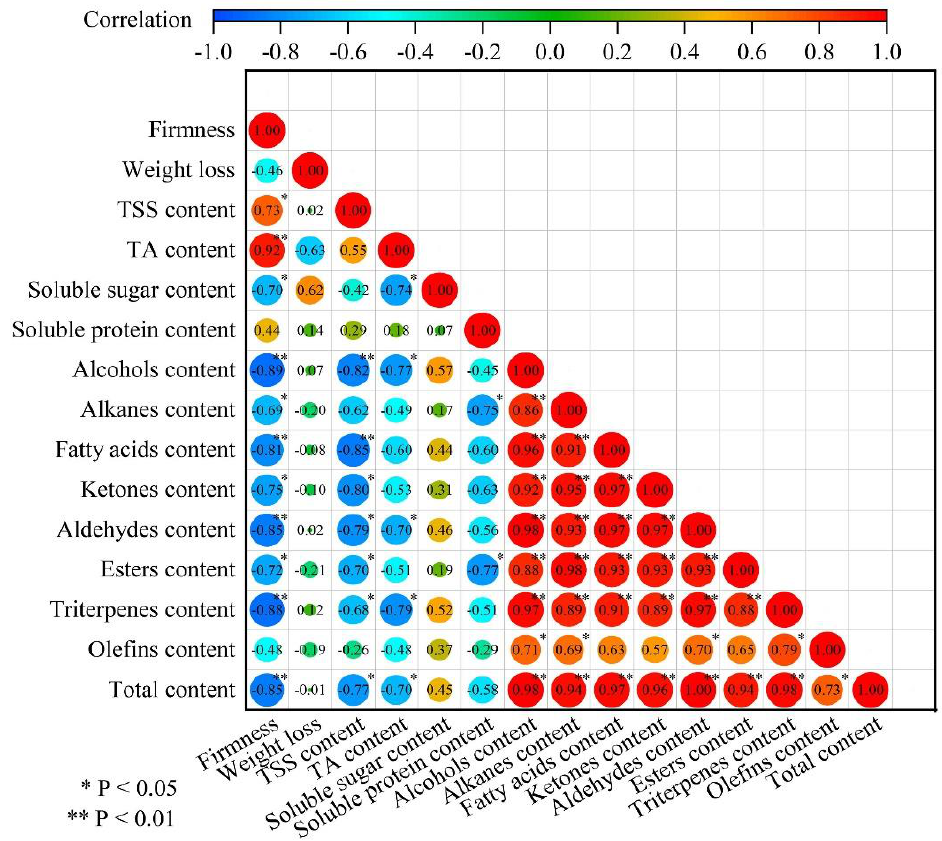
Figure 6. Correlation analysis between wax parameters and quality parameters among three plum cultivars during storage at room temperature. Note: the Pearson correlation coefficient is expressed by the size of the circle. Blue color indicates negative correlation, and red color indicates positive correlation. * represents significant difference ( p < 0.05), and ** represents extremely significant difference ( p < 0.01).